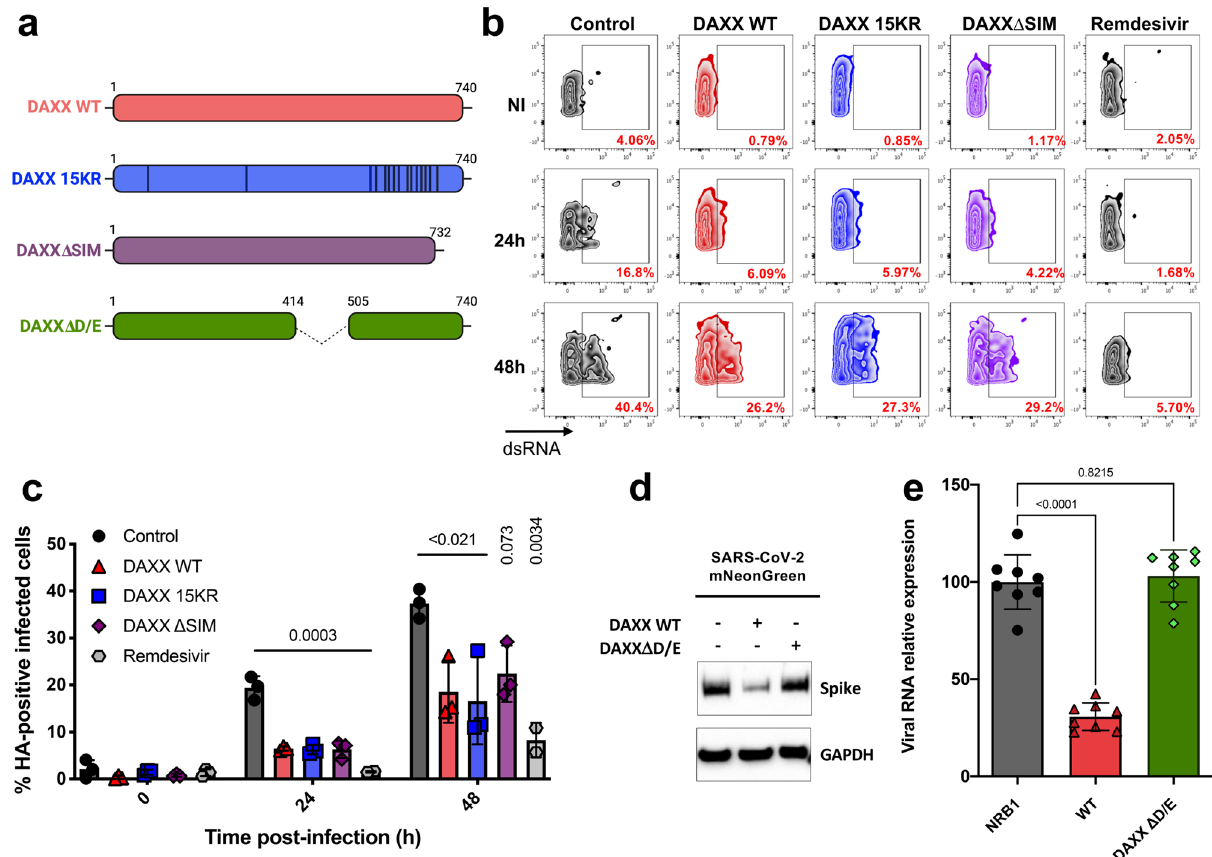
Fig. 4 DAXX restriction of SARS-CoV-2 is dependent on its chaperone activity but SUMOylation-independent. a Schematic of the DAXX mutants used. The fi fteen lysine residues of DAXX 15KR have been mutated to arginine. DAXX Δ SIM lacks the 732 – 740 C-terminal residues. Both mutants were described in. 48 DAXX Δ D/E is lacking its 414-505 domain and has been described in 52 b , c SUMOylation-de fi cient DAXX mutants are still able to restrict SARS-CoV-2. 293T-ACE2 cells were transfected with HA-DAXX WT; HA-DAXX 15KR; HA-DAXX Δ SIM; or with HA-NBR1 as negative control plasmid. 24h after transfection, cells were infected with SARS-CoV-2 at an MOI of 0.1. When indicated, cells were treated with remdesivir at the time of infection. After 24h or 48h, infected cells were double-stained for dsRNA (to read out infection) and HA (to read out transfection ef fi ciency) and acquired by fl ow cytometry. The percentage of infected cells among HA-positive (transfected) cells for one representative experiment is shown in ( b ), for the mean ±SD of 3 independent experiments in ( c ). Statistics: one-way ANOVA using Dunnett ’ s test, Holm corrected. P values are indicated on the graph. d , e : The chaperone activity of DAXX is required for SARS-CoV-2 restriction. 293T-ACE2 cells were transfected with DAXX WT or with the DAXX Δ D/E mutant. 24h after transfection, cells were infected with SARS-CoV-2 mNeonGreen at an MOI of 1. After 24h, the levels of Spike and GAPDH levels were analyzed by Western Blot ( d ). A Western Blot representative of 3 independent experiments is shown. In parallel, SARS-CoV-2 replication levels were measured by RT-qPCR targeting the 5 ʹ UTR and normalized against RPL13A transcript levels ( e ). The mean± SD of 4 independent experiments, with infections carried out in two biological replicates, is represented. Statistics: 1-way ANOVA using Dunnett ’ s test. P values are indicated on the graph. Source data are provided as a Source Data fi